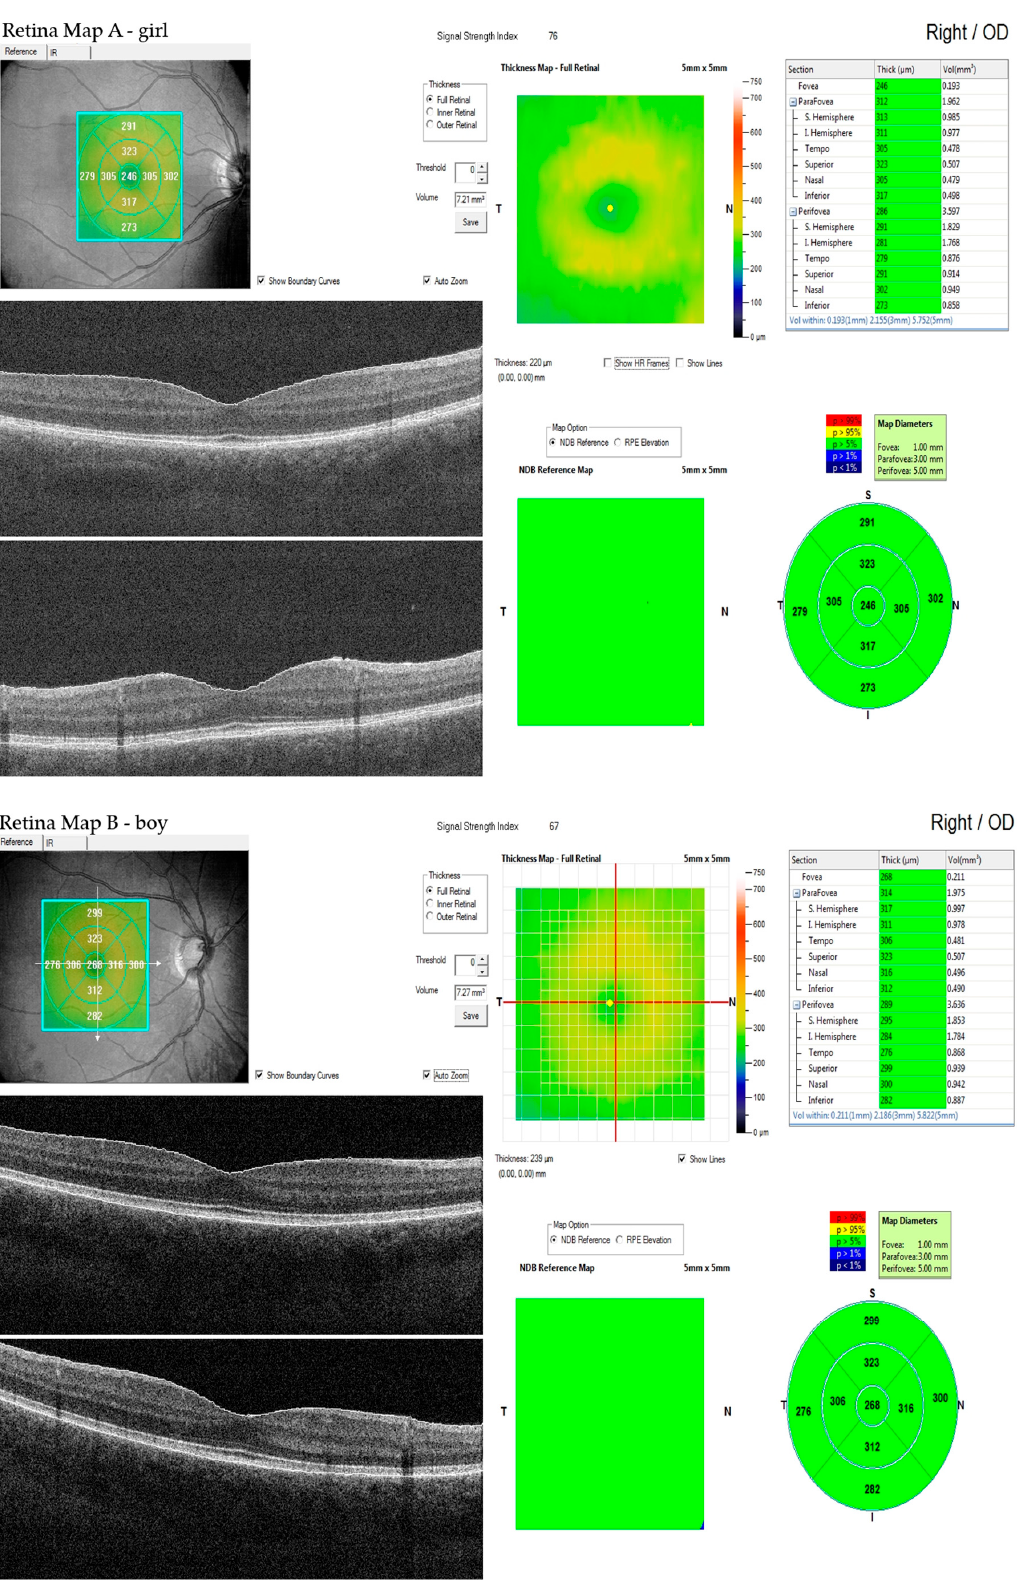
Figure 2. Representative OCT image reflecting measurement and the standard Retinal Thickness Map showing the foveal and parafoveal thicknesses. ( A ) girl, ( B ) boy.